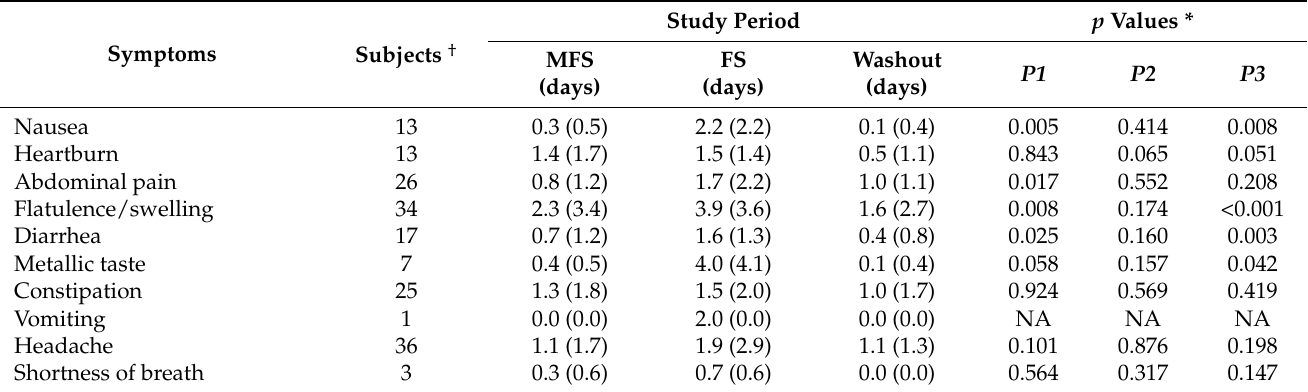
Table 6. Overall duration of symptoms related to iron